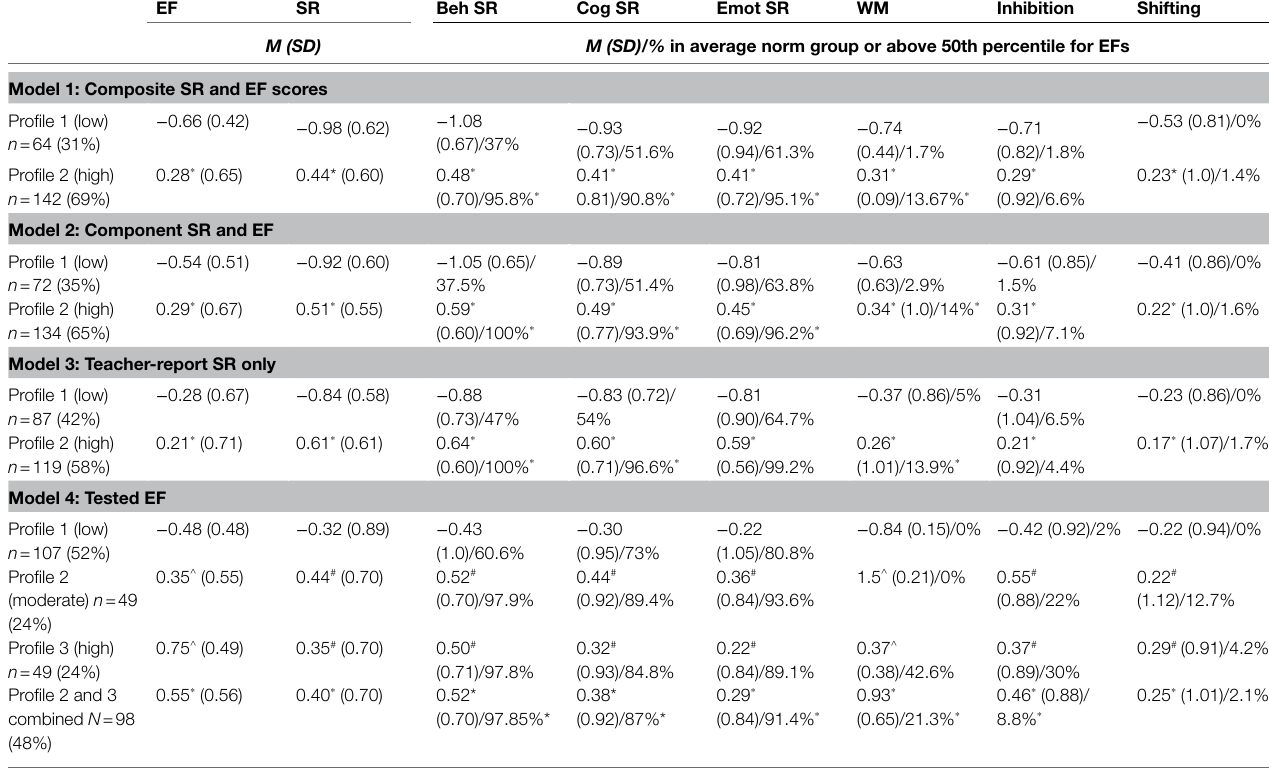
TABLE 3 | Profile differences on indicator measures and age norm